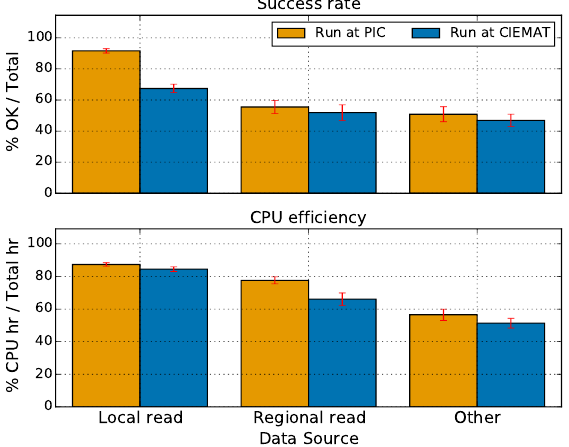
Figure 5: Success rate (top) and CPU e ffi ciency (bottom) per relative location of input data, for jobs run at PIC (left / orange bars) and run at CIEMAT (right / blue